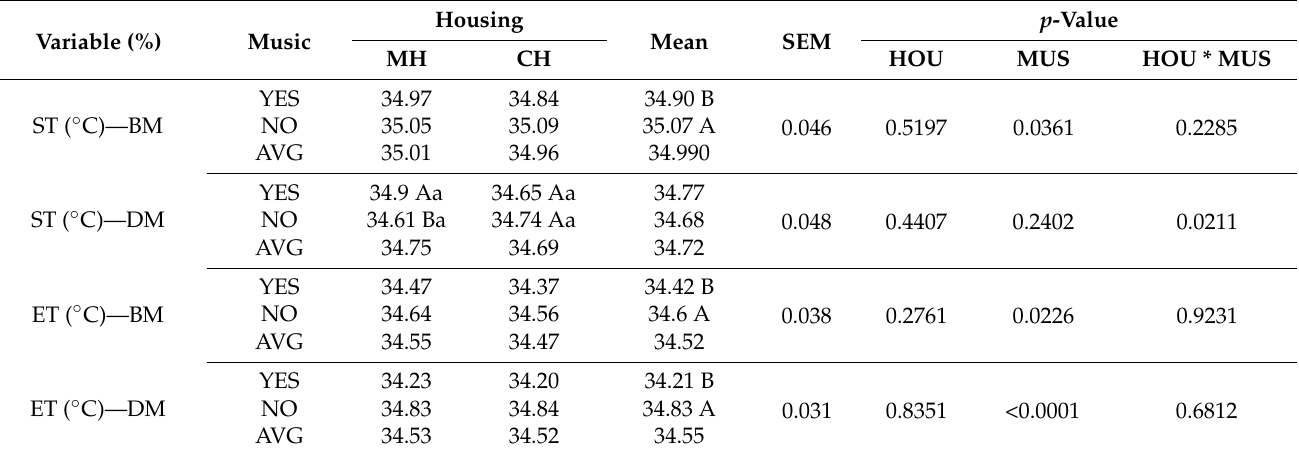
Table 3. Mean body surface temperature and eye temperature of lactating sows in mixed housing or collective housing before and during exposure to auditory environmental enrichment.